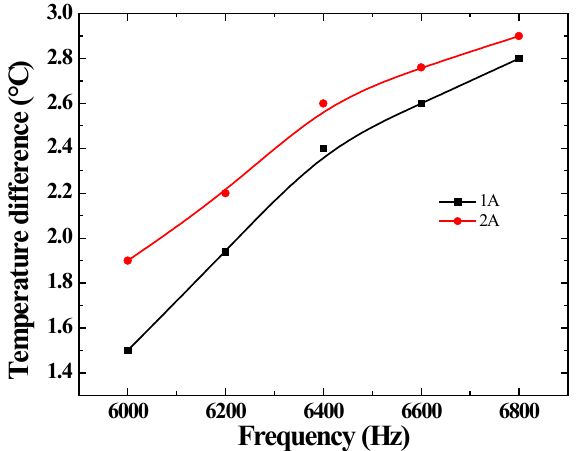
Figure 10. Temperature difference between the outlet and the inlet. The output displacement consists of two parts: (a) Magnetostrictive strain. The magnetostriction decreases when the temperature increases by 1000 ppm at 20 °C, and drops to 890 ppm at 40 °C. For this reason, as the temperature increases, the output displacement decreases. (b) Thermal expansion strain. This is caused by temperature change, and can be calculated by y T = α T ∆ T , where α T is the thermal expansion coefficient. The thermal expansion strain increases the output displacement. In fact, the influence of temperature on the magnetostrictive strain is larger than that of the thermal expansion strain. Therefore, the output displacement decreases as the temperature rises. The amplitudes of the output displacement of the GMT are measured by the laser displacement sensor, as shown in Figure 11.